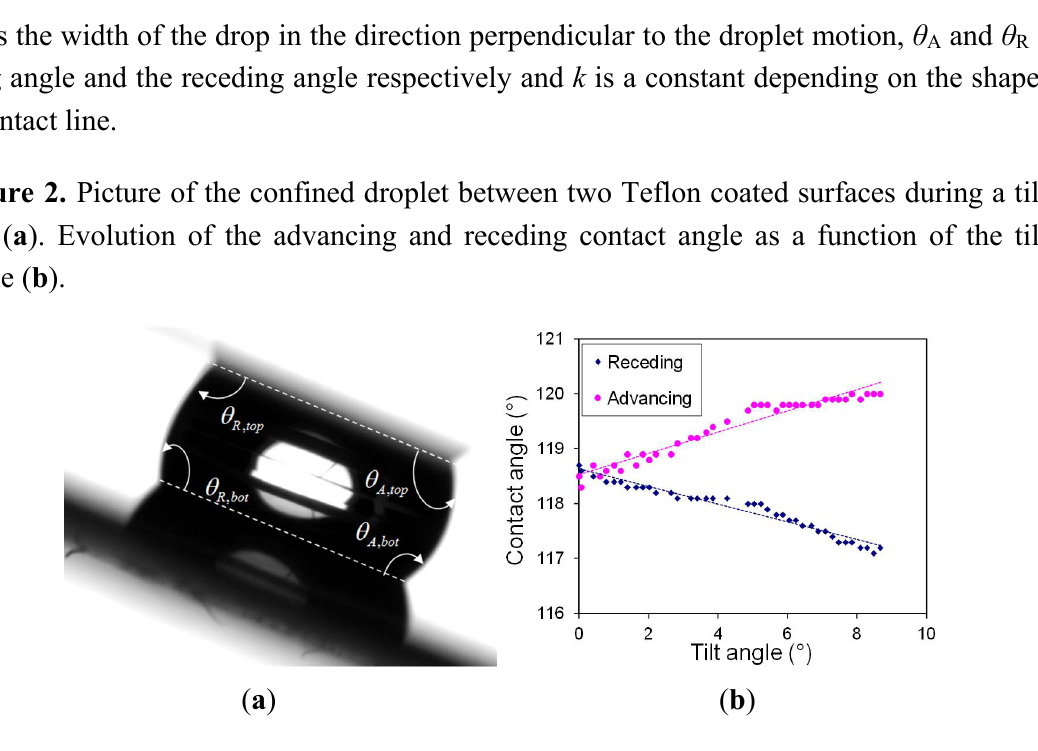
Figure 3. Measurement data for the evolution of the advancing and receding contact angle ( a ) and the total contact line friction force ( b ) as a function of the droplet velocity for a moving, confined droplet between two Teflon